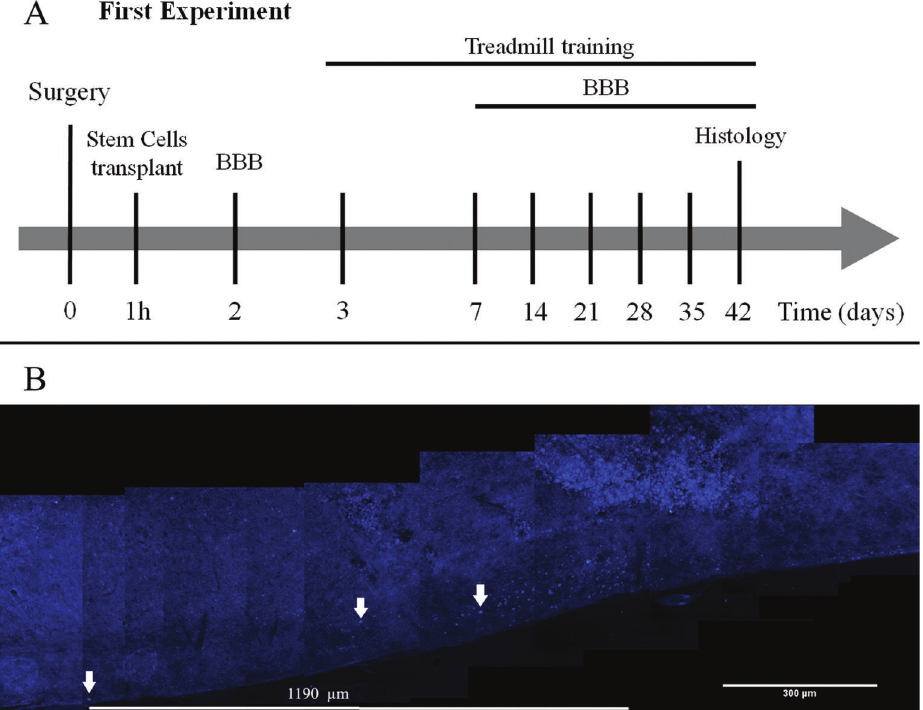
Figure 1. Experimental design ( A ). Photomicrographs of stem cells from human exfoliated deciduous teeth (SHEDs) labeled with Hoechst 33342 ( B ). SHEDs survived and migrated 1.190 m m along the spinal cord (arrows). BBB: Basso, Beatie, and Bresnahan